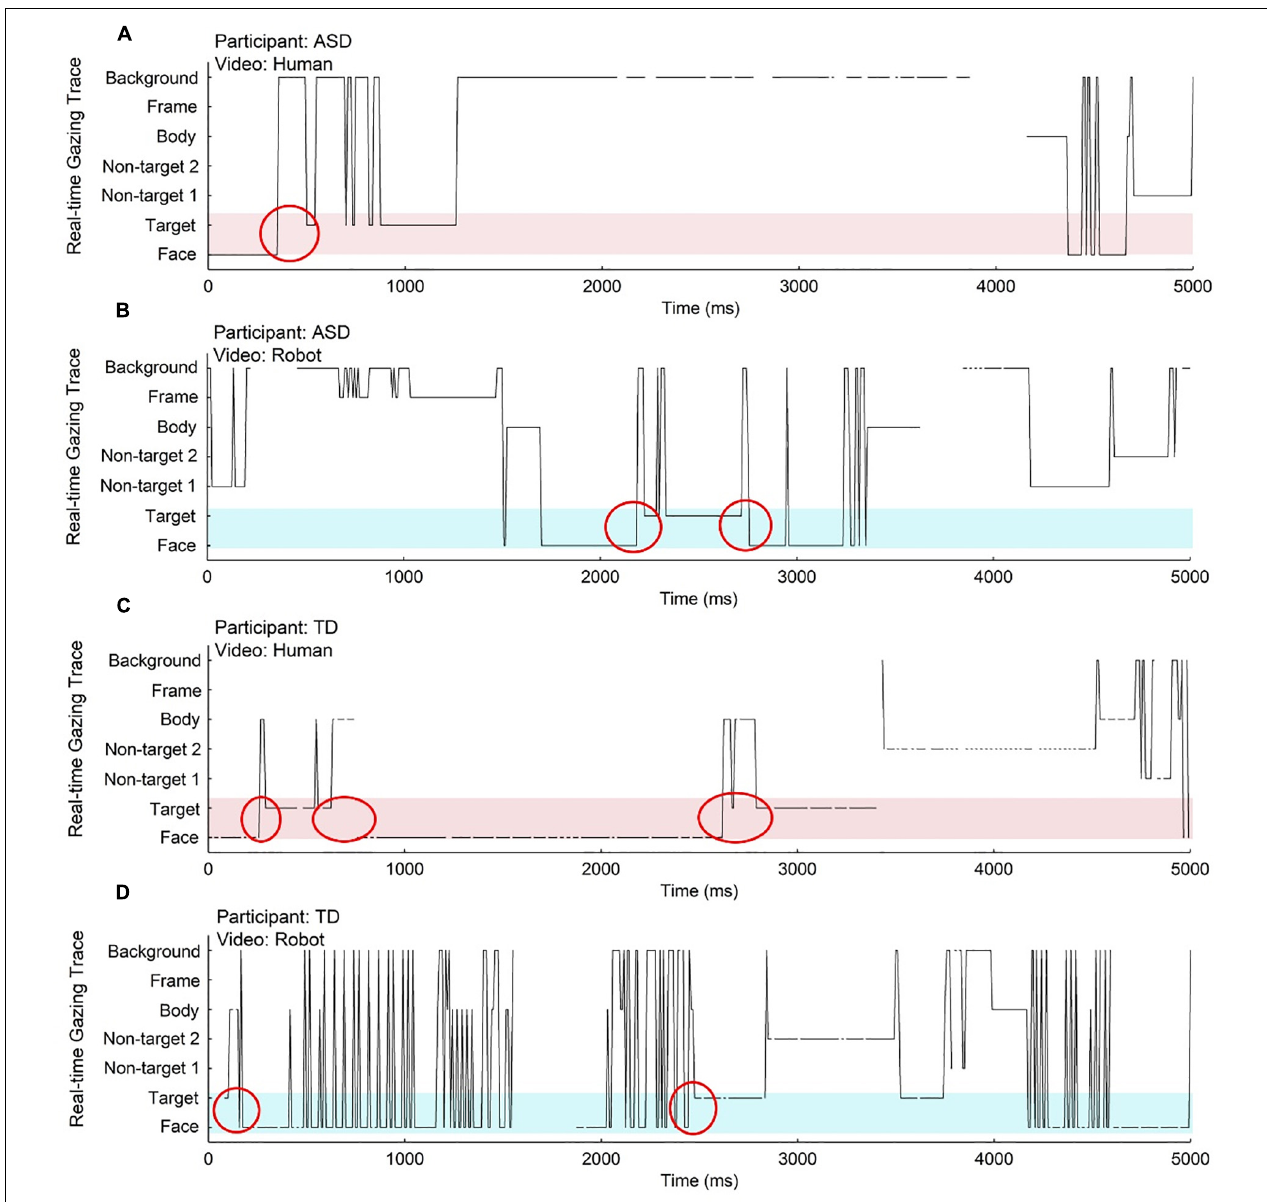
FIGURE 2 | The real-time gaze traces of two participants, one child with ASD (A,B) and one TD child (C,D) during the joint attention segment of videos in each condition (human condition: A,C ; robot condition: B,D ). Different areas of interest are represented on the y axis, and the x axis represents time. Black lines represent eye movement traces, where each point corresponds to a fixation in one area of interest recorded at a certain time point. Red circles indicate gaze transitions between the agent’s face and the target. Light red and light blue shaded areas cover the face and target regions, which are used in the reference sequences in LCS analysis; joint attention behavior can be observed in these